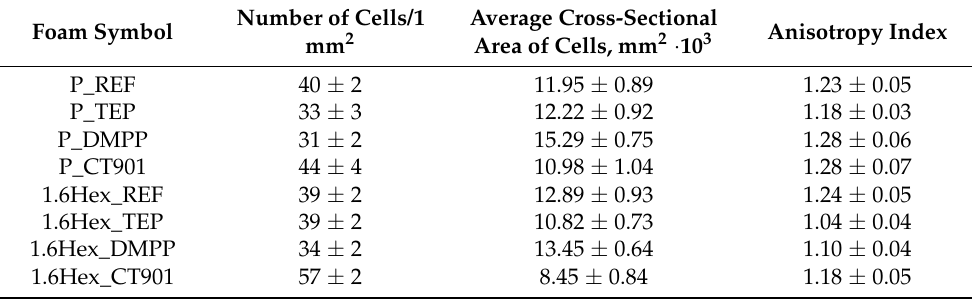
Figure 5. Microphotographs of the cell structure of polyurethane foams modified with 40 wt.% bio-polyol. Table 2. Parameters of foams cell structure in the direction parallel to the foam rise.